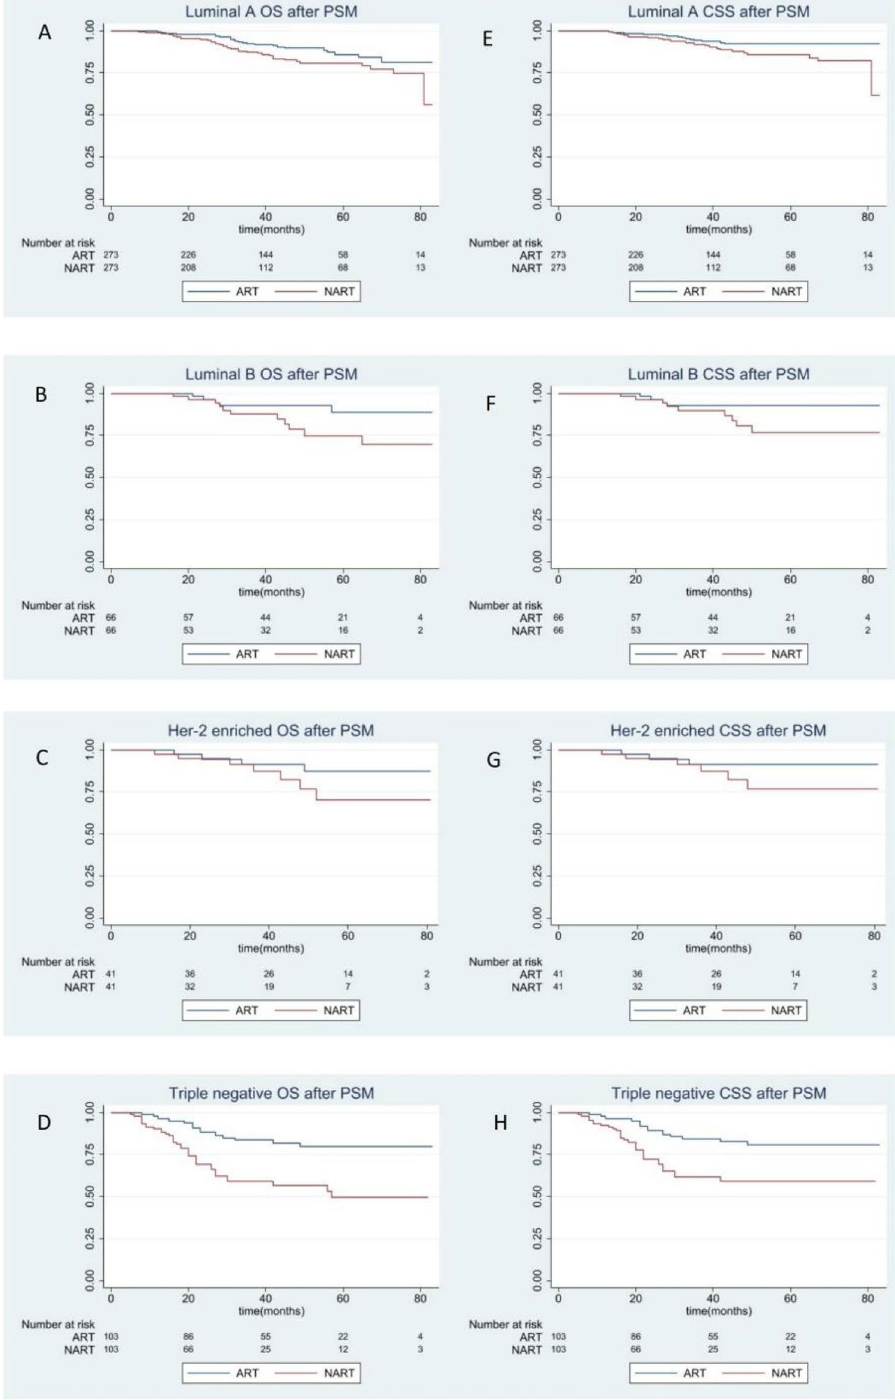
Figure 4. Overall and breast cancer–specific survival by radiation sequence with surgery in the molecular subtype subgroup based on propensity score (PS) matching-adjusted survival data. All P values based on PS matching-adjusted, two-sided log-rank test. Left column, overall survival: ( A ) Luminal A, ( B ) Luminal B, ( C ) HER-2 enriched, ( D ) Triple negative. Right column, breast cancer-specific survival: ( E ) Luminal A, ( F ) Luminal B, ( G ) HER-2 enriched, ( H ) Triple